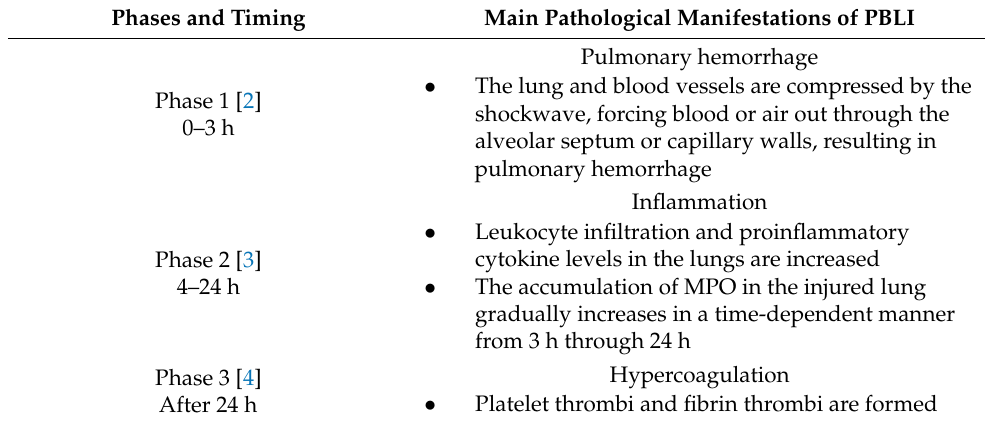
Table 1. The phases, timing, and corresponding pathological manifestations of PBLI